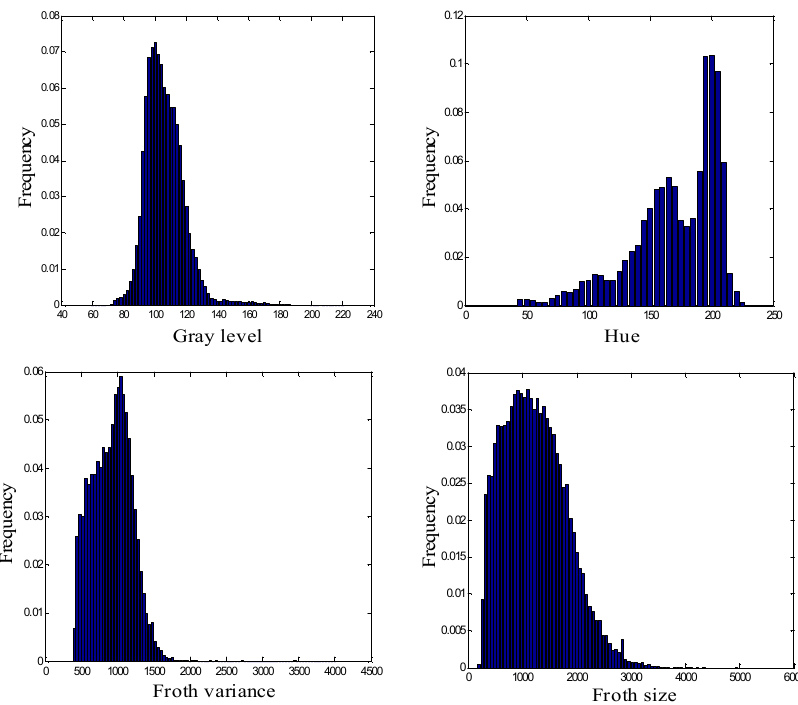
Figure 4. Probability statistical distributions of optimal froth image features. Table 5. Optimal intervals of froth image features.